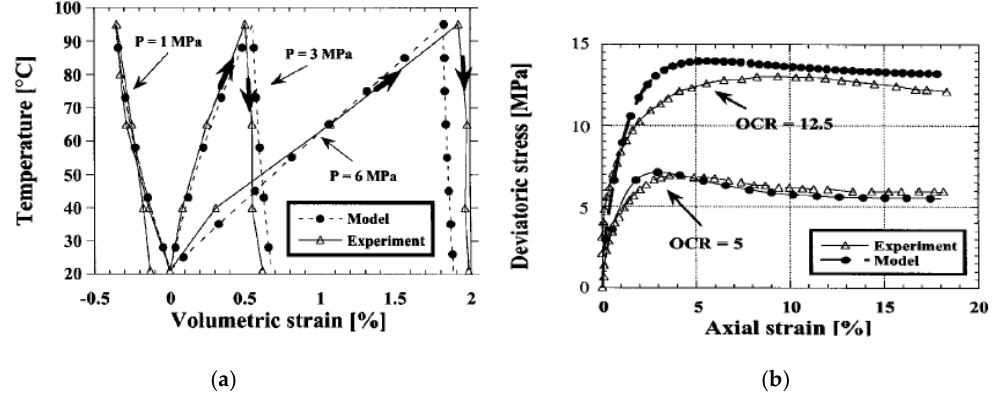
Figure 8. Comparison of experimental results (from [178]) and numerical predictions with the proposed model: ( a ) Thermal loading/unloading under constant isotropic stress; ( b ) drained triaxial results and numerical simulations at 20 °C for two OCR values [178].